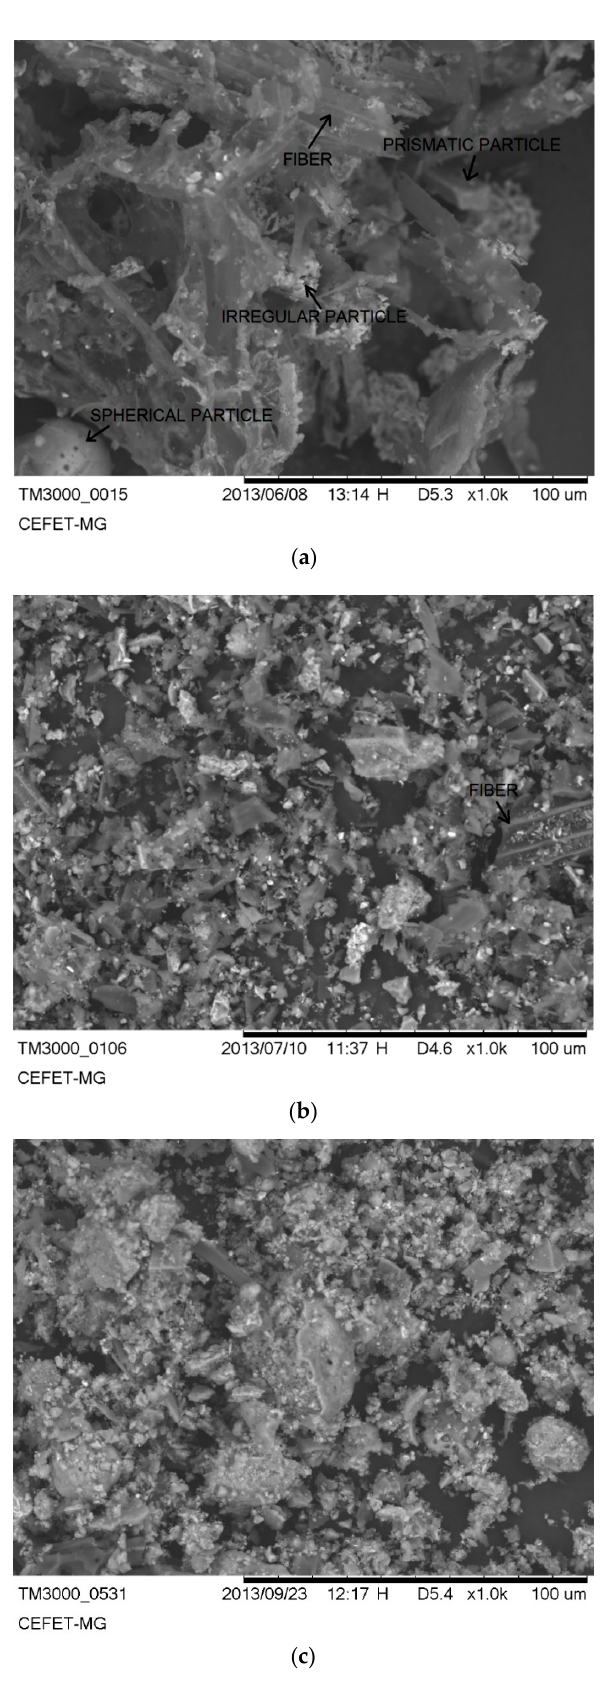
Figure 9. SEM of SCBAs: ( a ) SCBA AC; ( b ) SCBA G; ( c ) SCBA RG.